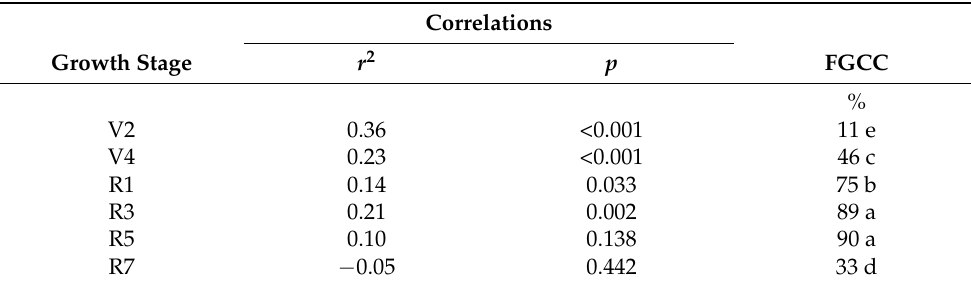
Table 5. Simple correlation coefficients for the relationship between soybean seed yield and fractional green canopy cover (FGCC) measured at different growth stages throughout the growing season for the combined environments in 2019 and 2020.